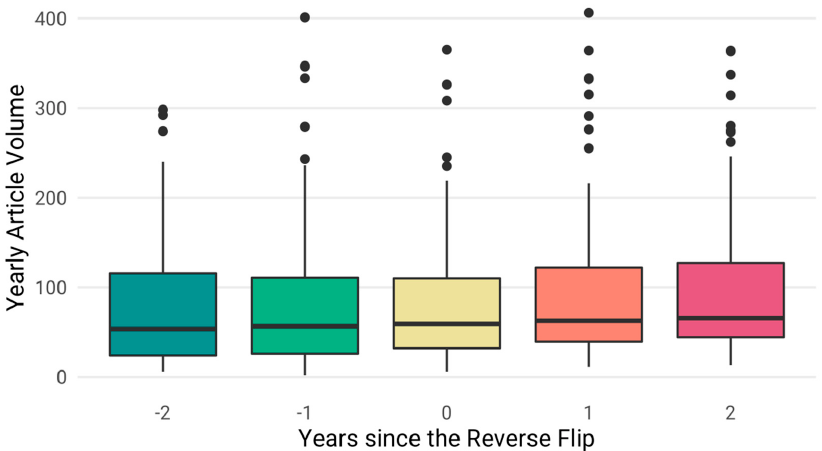
Figure 11. Development of publication volume two years before and after the reverse flip ( Y -axis limited to 400 articles per year).